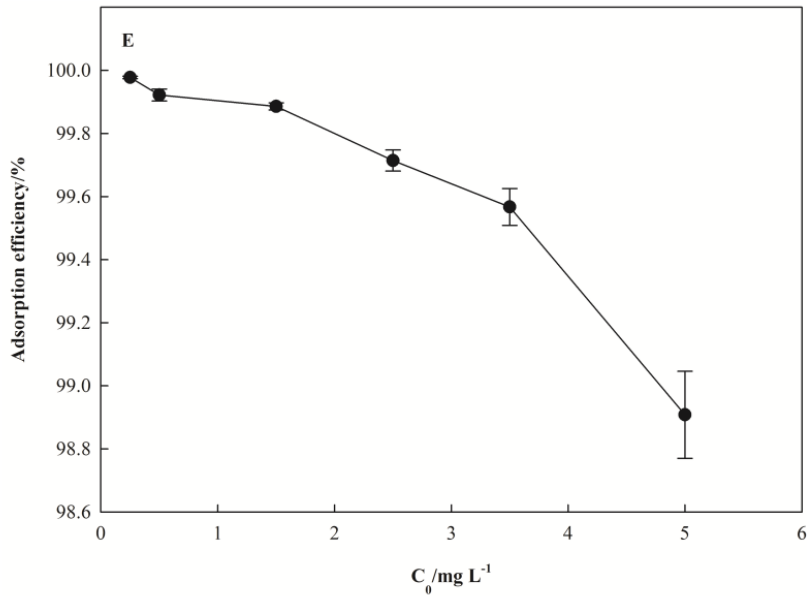
Figure 3. Effect of adsorption conditions on the removal rate of Pb(II). ( A ) for pH, ( B ) for dosage of I-S m , ( C ) for adsorption temperature, ( D ) for adsorption time, ( E ) for Pb(II) initial concentration.